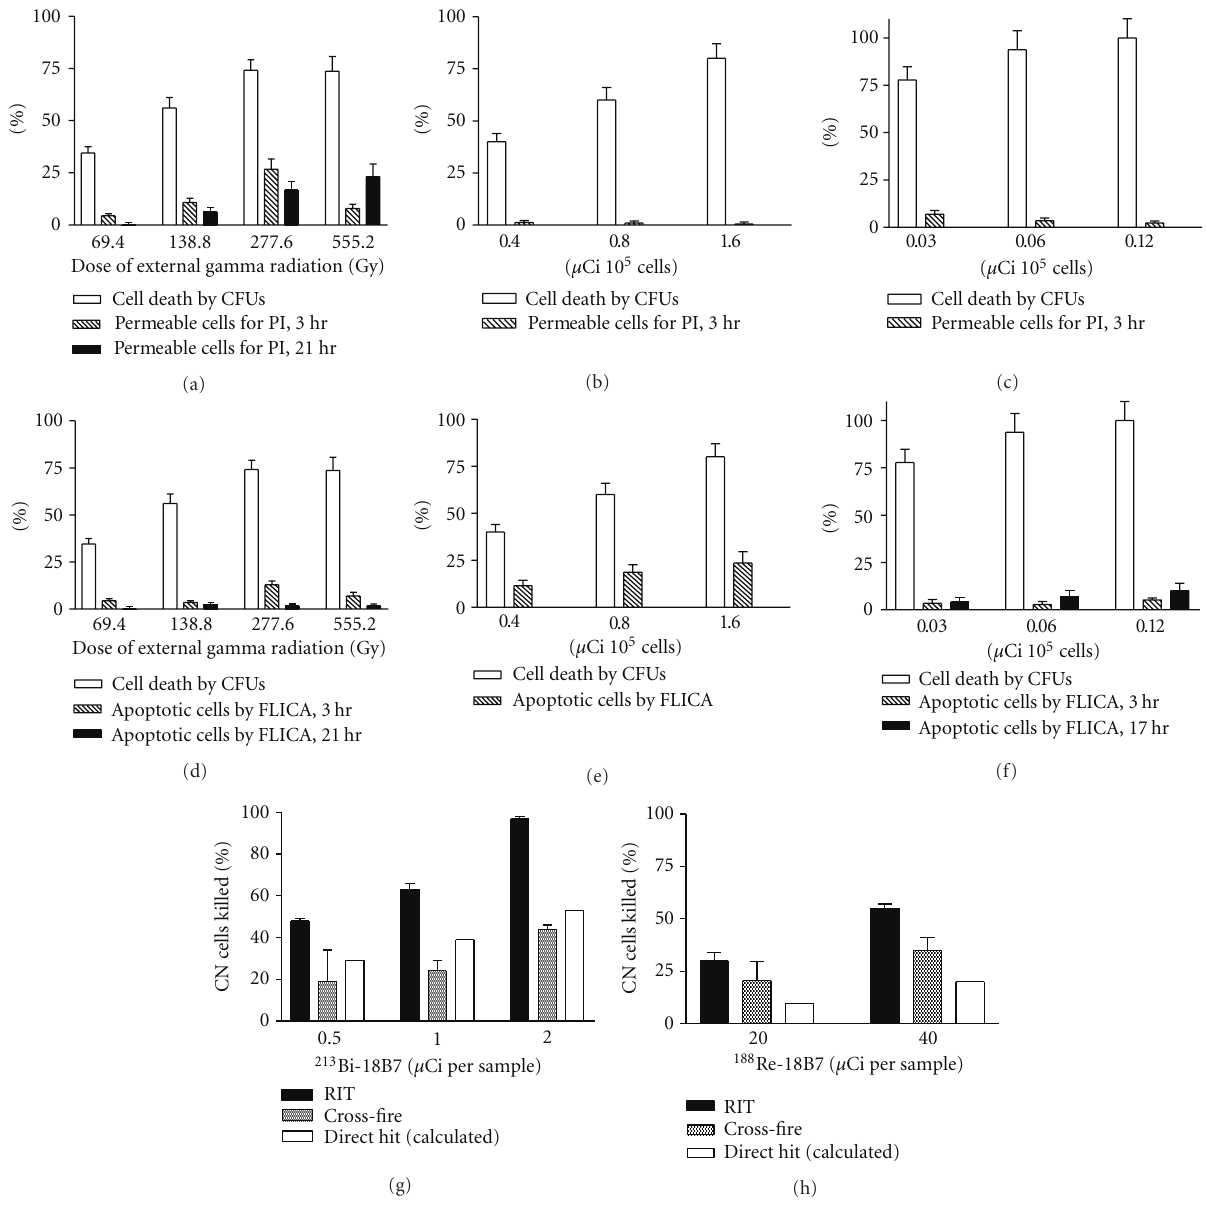
Figure 4: Contribution of di ff erent radiobiological e ff ects to RIT of CN with 213 Bi-18B7 and 188 Re-18B7 mAbs. (a–c) show CFUs and PI permeability for: (a) external gamma radiation; (b) 188 Re-18B7; (c) 213 Bi-18B7. (d–f) show CFUs and apoptosis levels by FLICA: (d) external gamma radiation; (e) 188 Re-18B7; (f) 213 Bi-18B7. (g–h) show contribution of “cross-fire” and “direct hit” towards killing of CN cells: (g) “cross-fire” and “direct hit” for 213 Bi-18B7; (h) “cross-fire” and “direct hit” for 188 Re-18B7. The contribution of “direct hit” towards cell killing was calculated by subtracting percentage of cells killed by “cross-fire” from percentage of cells killed by RIT; adapted from[19,